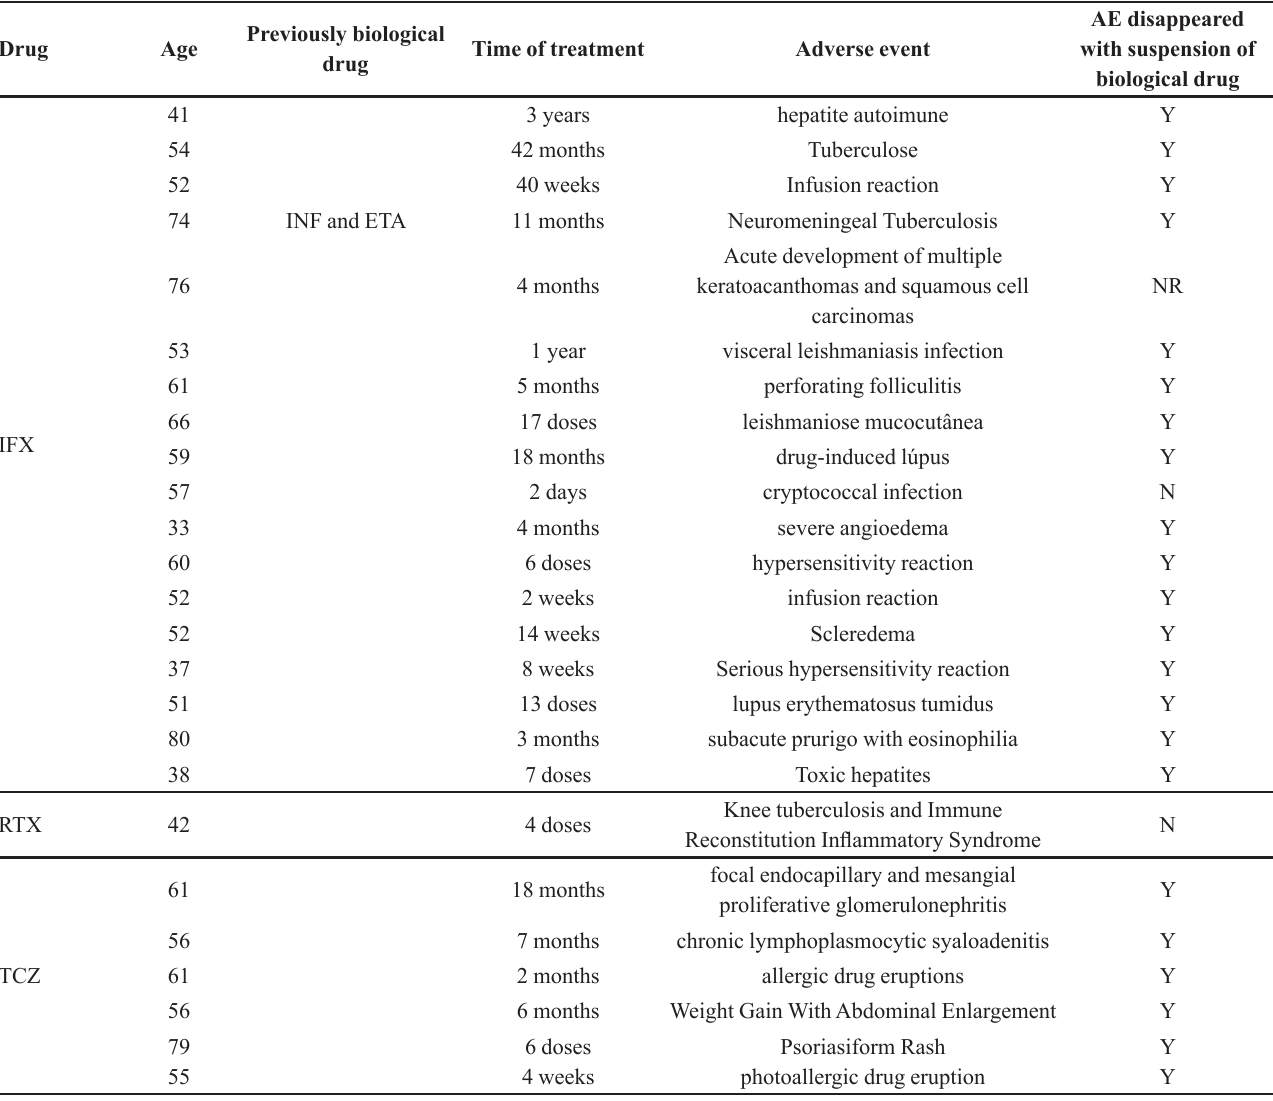
TABLE II - Description of confirmed adverse event